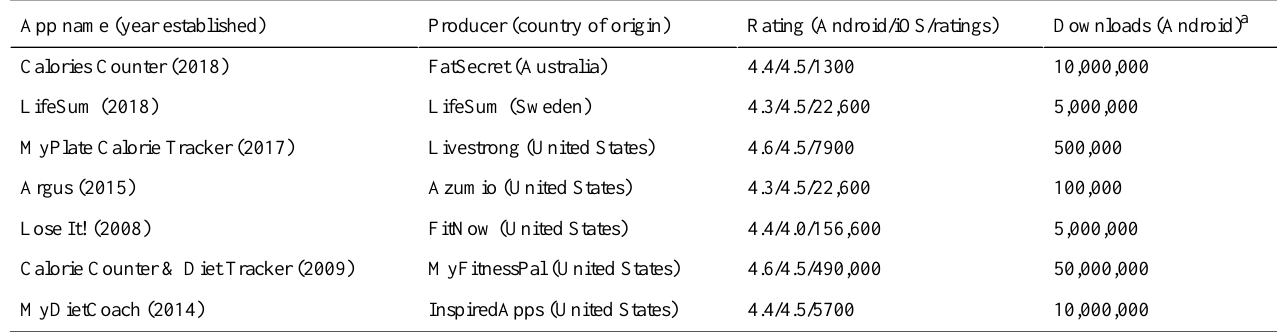
Table 1. Characteristics of the diet-tracking apps used in the United